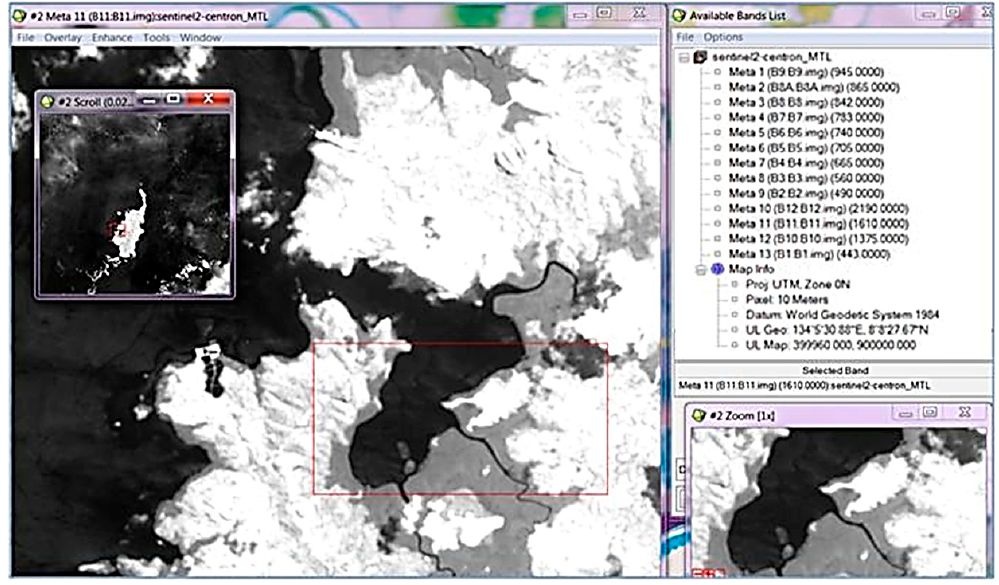
Figure 4. Sentinel-2 satellite image on the Republic of Palau on 4 July 2017, with a 10 m spatial resolution. Enhanced Band 11 was used, showing the land (white), the mangrove cover (grey), the sea (black).